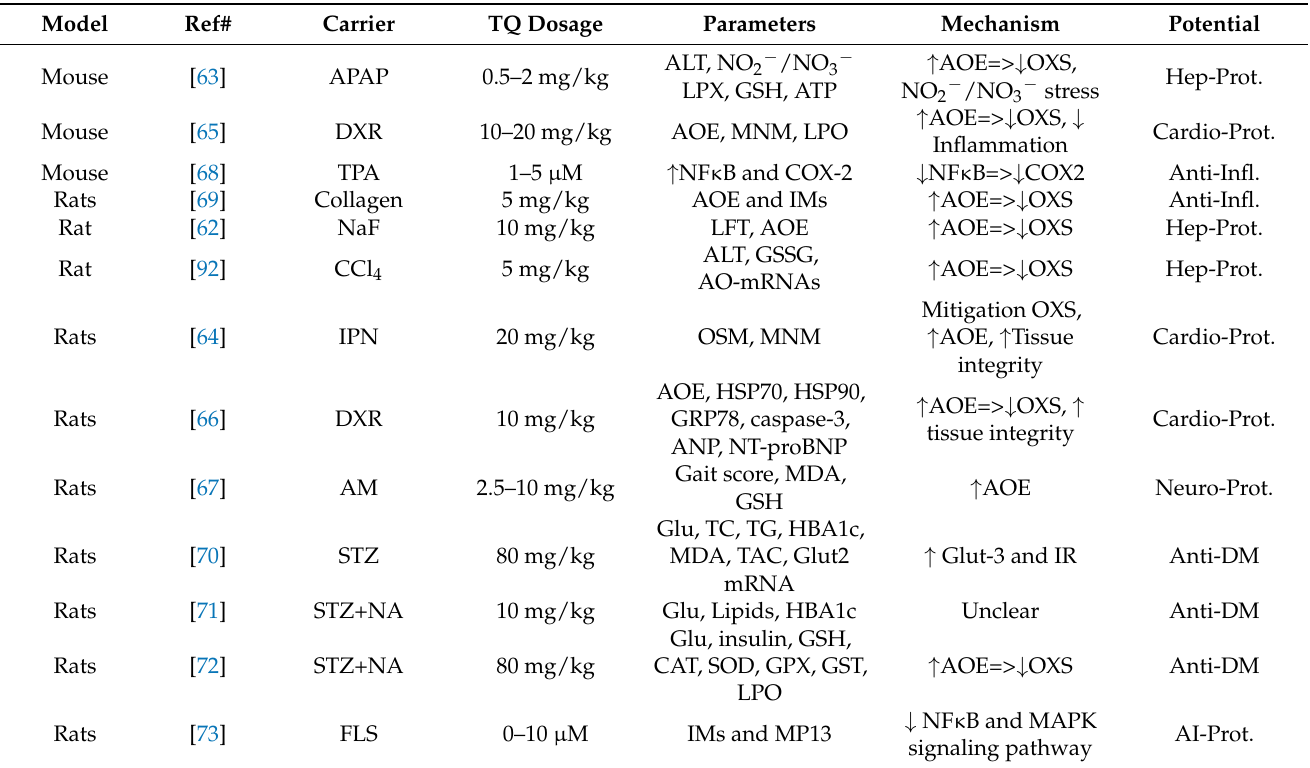
Table 4. Rodent Models targeting the Therapeutic Potential of